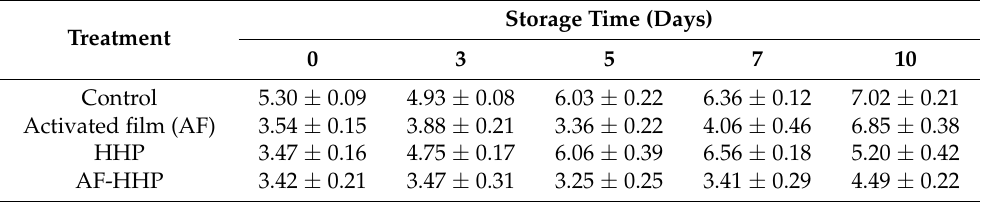
Table 1. Viable cell counts for Listeria in sea bream fillets challenged with the bacterium and stored under refrigeration. Fillets were packed in polyethylene-polyamide bags without any treatment (controls), or in bags activated with 0.5% thymol plus 80 mg/mL enterocin AS-48. When indicated, packed fillets were treated by HHP (300 MPa, 5